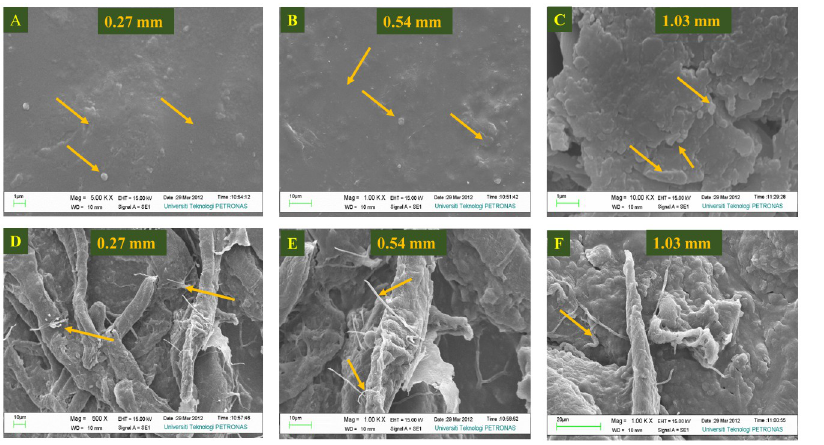
Fig 2. SEM images of non-biodegraded (A, B & C) and biodegraded (D, E & F) SRF